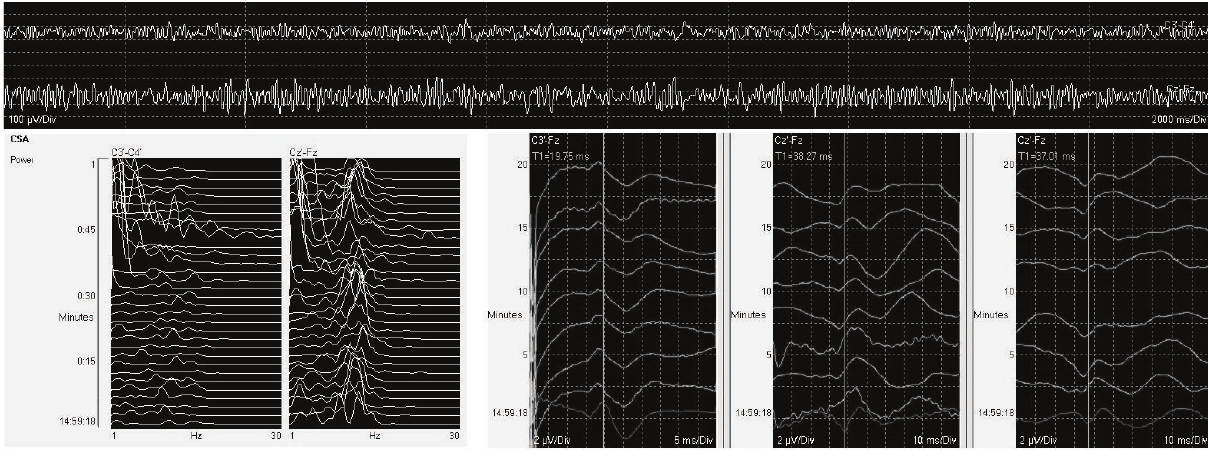
Figure 2: Screenshot of continuous EEG, spectral EEG analysis, and SSEPs (somatosensory evoked potentials) at the end of the procedure. EEG monitoring under general anesthesia shows persistence of 𝛼 -like activity (top) with a peak frequency around 9-10Hz (left). Right corner of the image: SSEPs monitoring is shown. Physiological neuraxial propagation of peripheral stimuli (darker line) with no time delay is seen (from left to right: the first column is right upper limb channel, and then the right lower limb and the left lower limb channels are shown, second and third column,